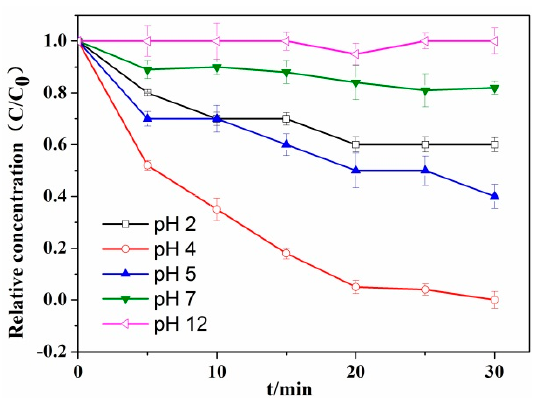
Figure 9. Influence of pH value on the Cr(VI) photocatalytic reduction by RCP-AG(15) under visible light with 40 µmol/L formic acid.